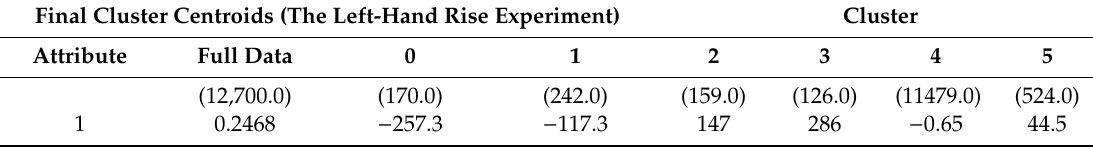
Table 2. Left-hand rise EEG data clustering